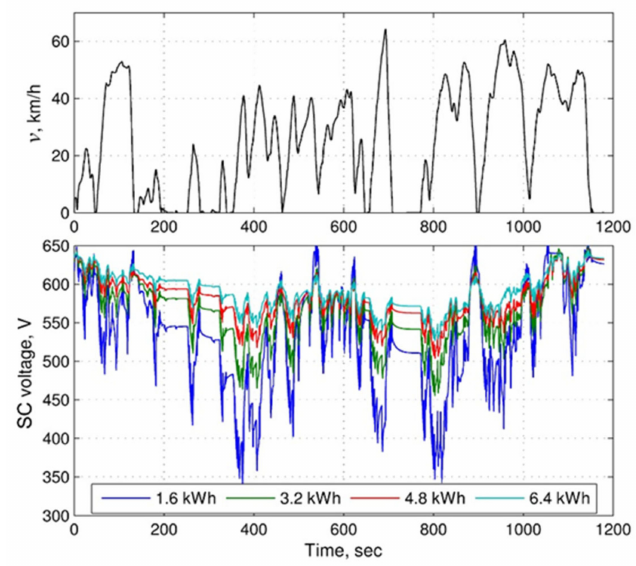
Figure 13. Supercapacitor voltage dynamics depending on the ESS energy content.